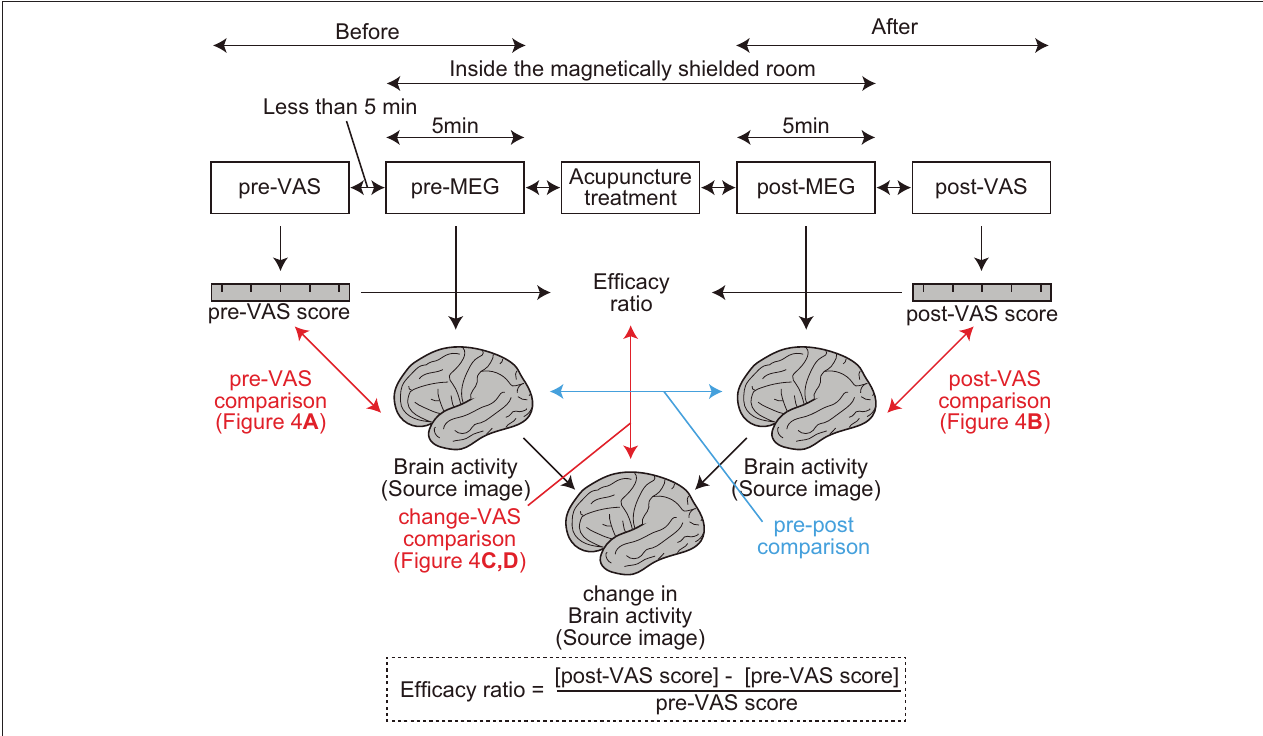
FIGURE 1 | Procedures and parameters of the study. Two visual analog scale (VAS) assessments, two magnetoencephalography recordings, and one acupuncture treatment were performed sequentially (top rectangles in the figure). The interval between each step was < 5min. The red arrows represent regression analyses between the brain activity and VAS readings. The blue arrow represents a comparison between brain activities. Efficacy ratio was defined as the ratio that represents the change in the subjective level of pain before and after acupuncture treatments. Change in brain activity was calculated using the SPM function